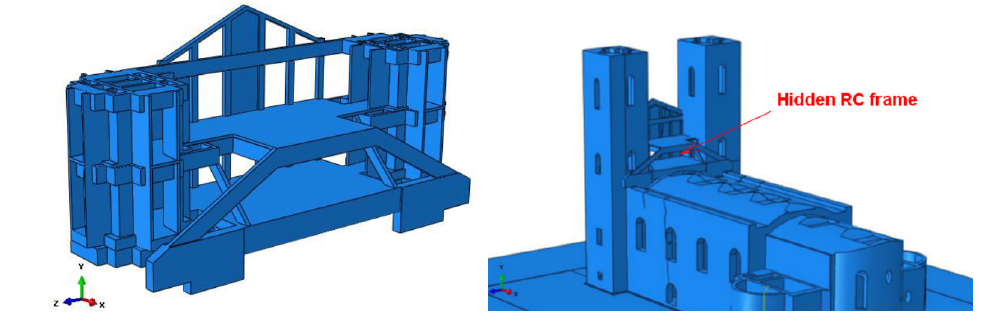
Figure 18. Proposed RC frame.